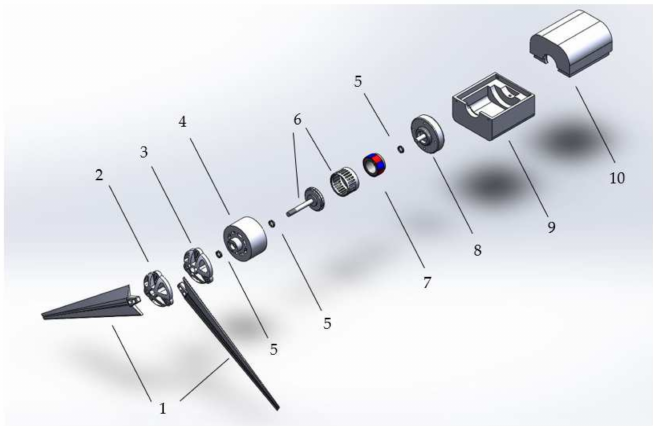
Figure 16. Exploded view of the developed